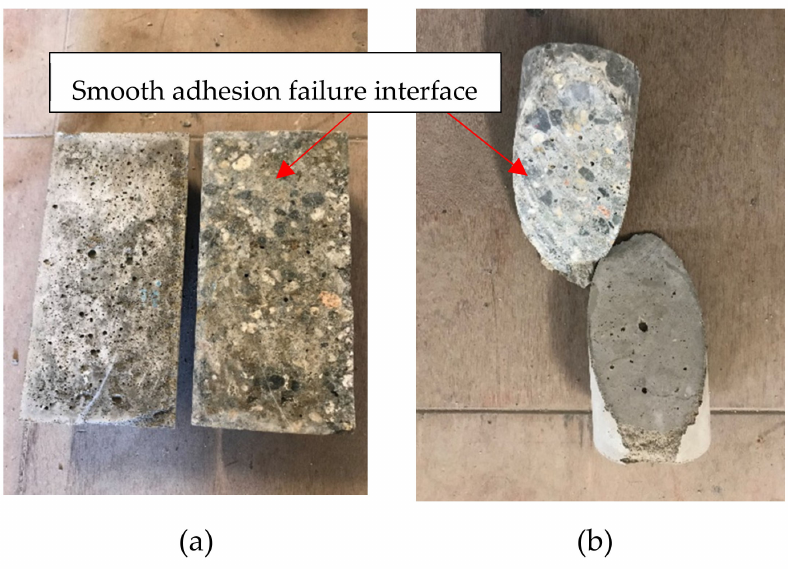
Figure 8. Failure patterns of bond test ( a ) Splitting tensile test ( b ) Slant shear test.